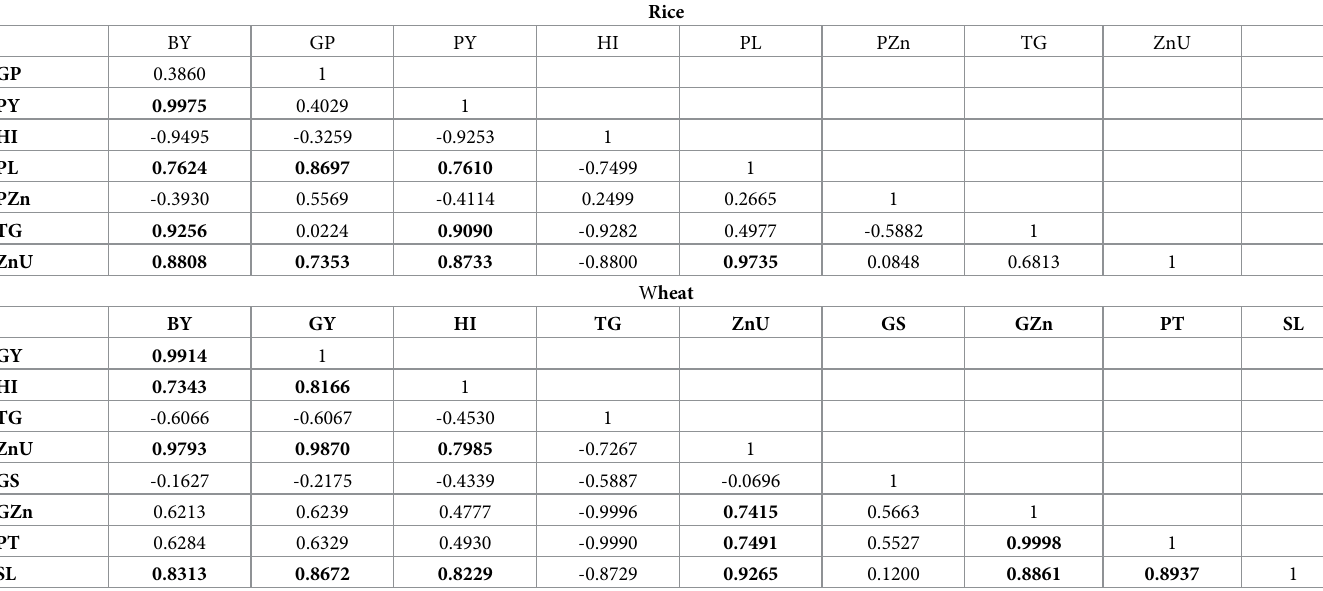
Table 5. Correlation among parameters influenced by BAZU application @125 kg ha -1 (T4) in four different sites (MTN, FSD, SWL, LHR).